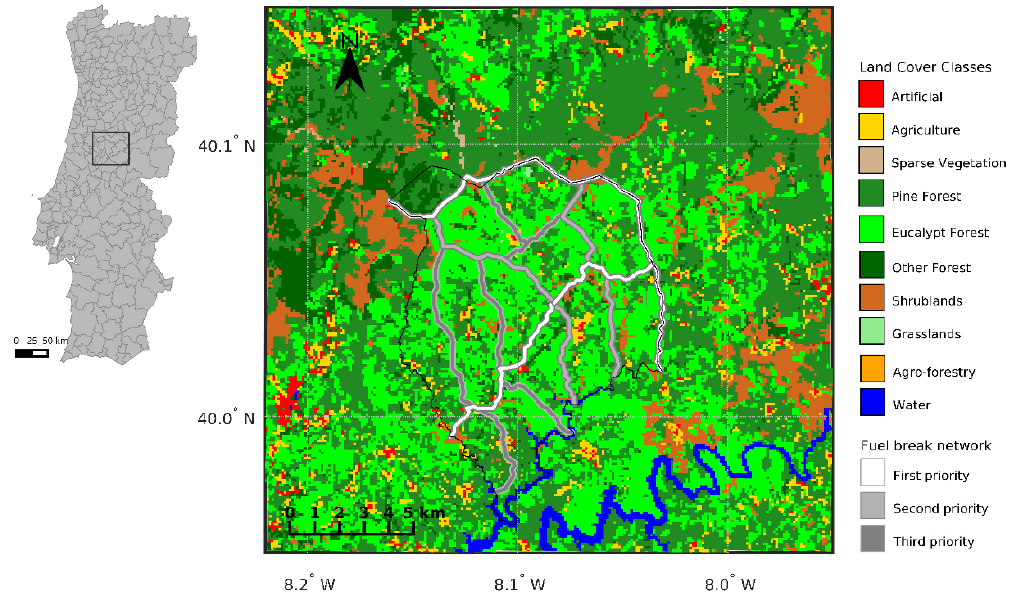
Figure 1. Study region: land cover and spatial context. Land cover classes derived from the Portuguese 2015 land use map; fuel break network design is explained in Section 3.2.